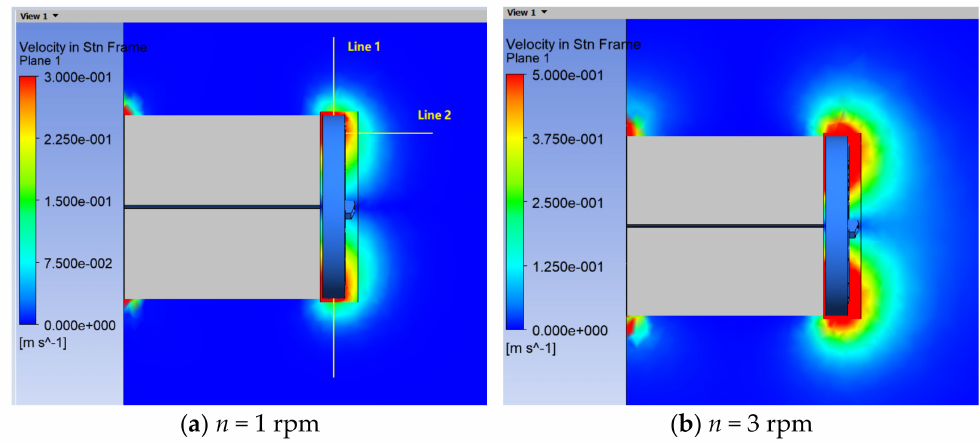
Figure 9. Numerical simulation results.